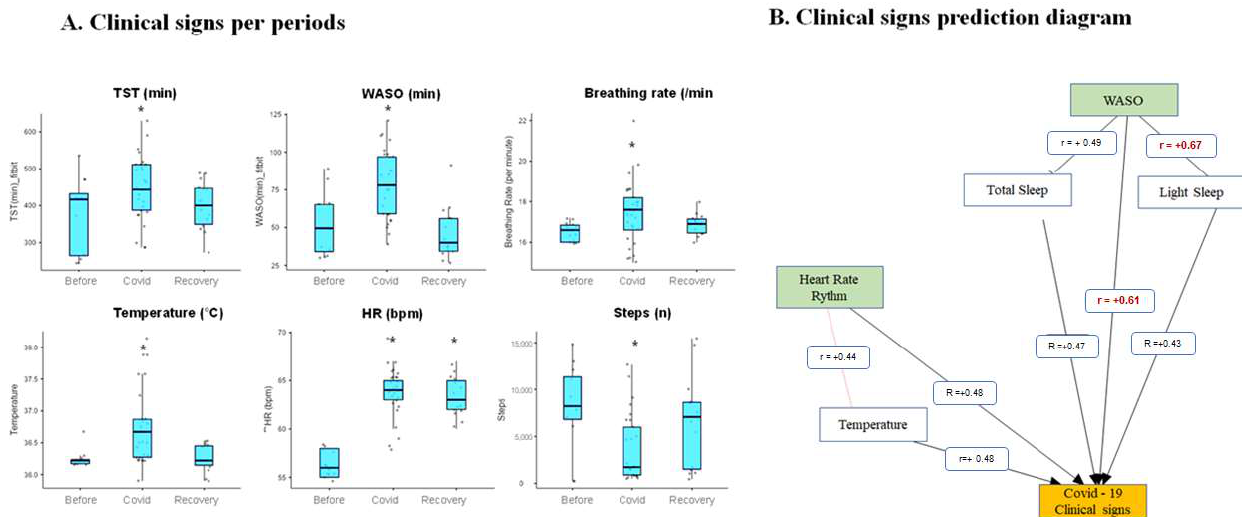
Figure 2. ( A ) Average physiological parameters before, during, and after SARS-CoV-2 (COVID) infection and ( B ) Correlation analysis between TST, WASO, temperature, heart rate rhythm, light sleep, and COVID-19 clinical signs. * is a significant difference with before SARS-CoV-2, (r) are Pearson correlation coefficients between values.